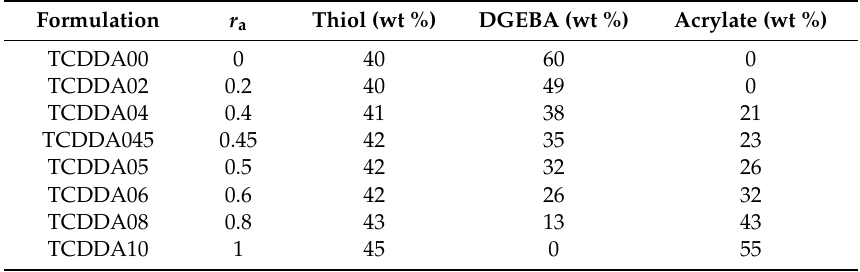
Table 1. Compositions of the di ff erent formulation of